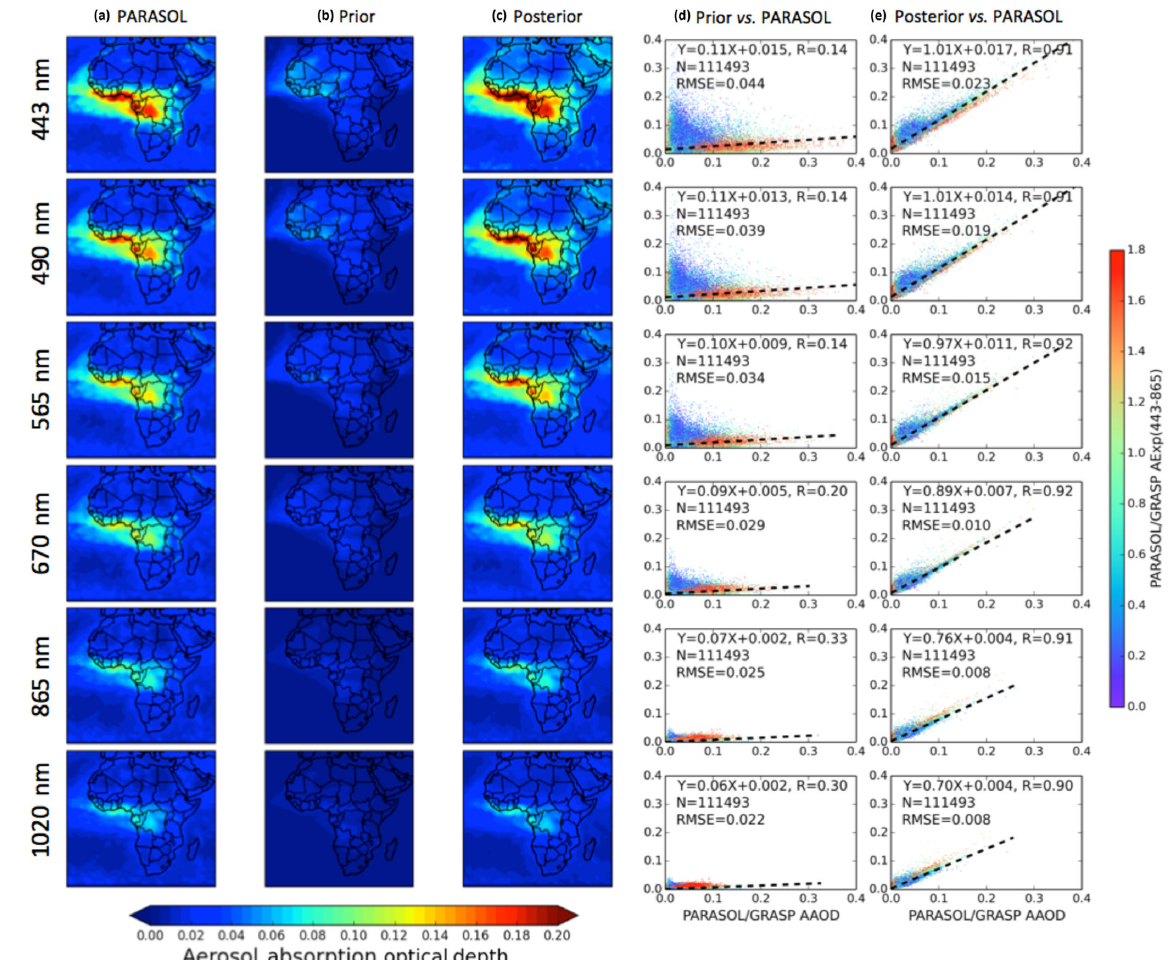
Figure 12. Same as Fig. 11, but for AAOD.